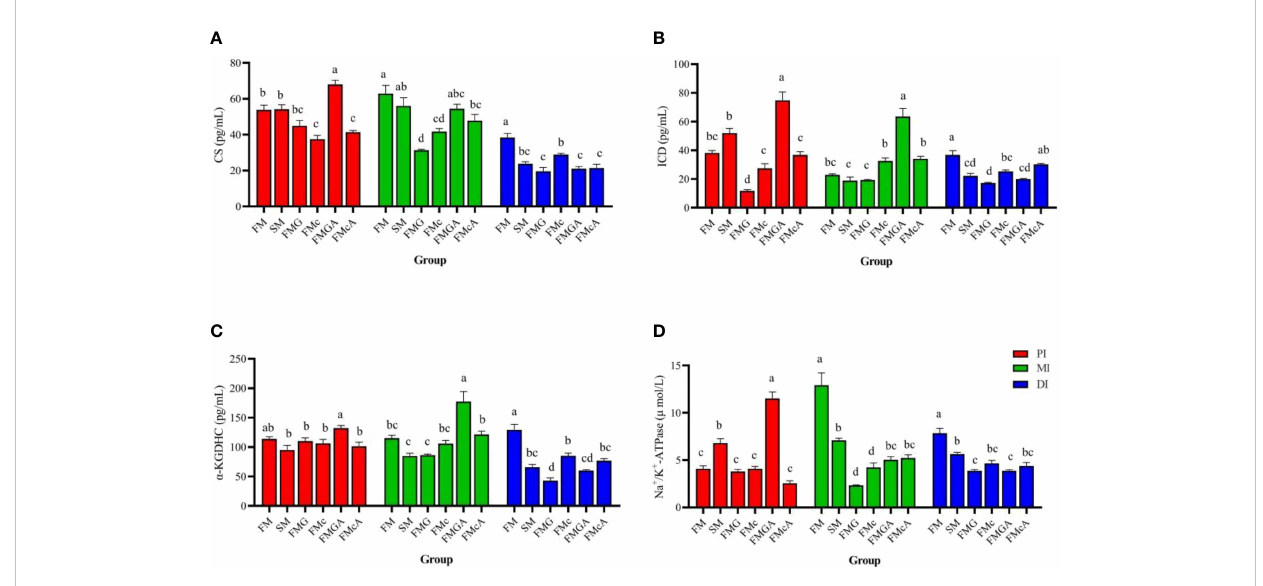
FIGURE 8 Key enzymes in the tricarboxylic acid cycle and Na + /K + -ATPase in the intestine fed with diets containing fi shmeal (FM), soybean meal (SM), glycinin (FMG). B-conglycinin (FMc), AKG+ glycinin (FMGA) AKG+B-conglycinin (FMcA) after eight weeks. PI, proximal intestine; MI, mid intestine; DI, distal intestine. (A) CS, Citrate synthase; (B) ICD, Isocitarte dehydrogenase; (pg/mL) (C) a-KGDHC, a-ketaglutarte dehydrogenase complex (pg/mL); (D) Na+/K+-ATPase (umol/L). Data are presented as means +SE, (n = 3). a, b, c Mean values with different letters were signi fi cantly different